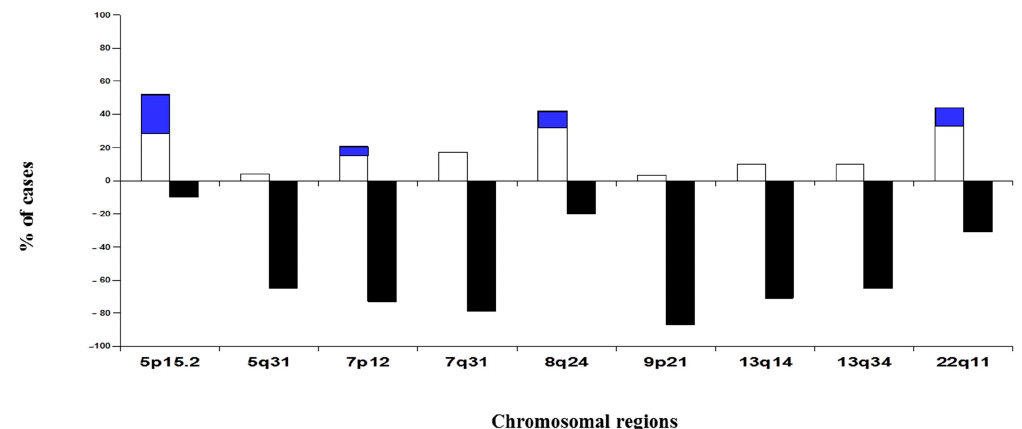
Figure 1. Chromosomal abnormalities detected in pulmonary squamous cell carcinomas (SCC) pa- tients by FISH techniques (n = 48). This summary plot illustrates the frequency of copy number gains (plotted in white above zero values in the x -axis) and losses (plotted in black below zero values in the x -axis) identified in patients with SCC of the lung. The blue colour indicates the accumulated frequency of the amplification of the chromosomal region analysed, being able to discriminate the polysomies of the amplification of the